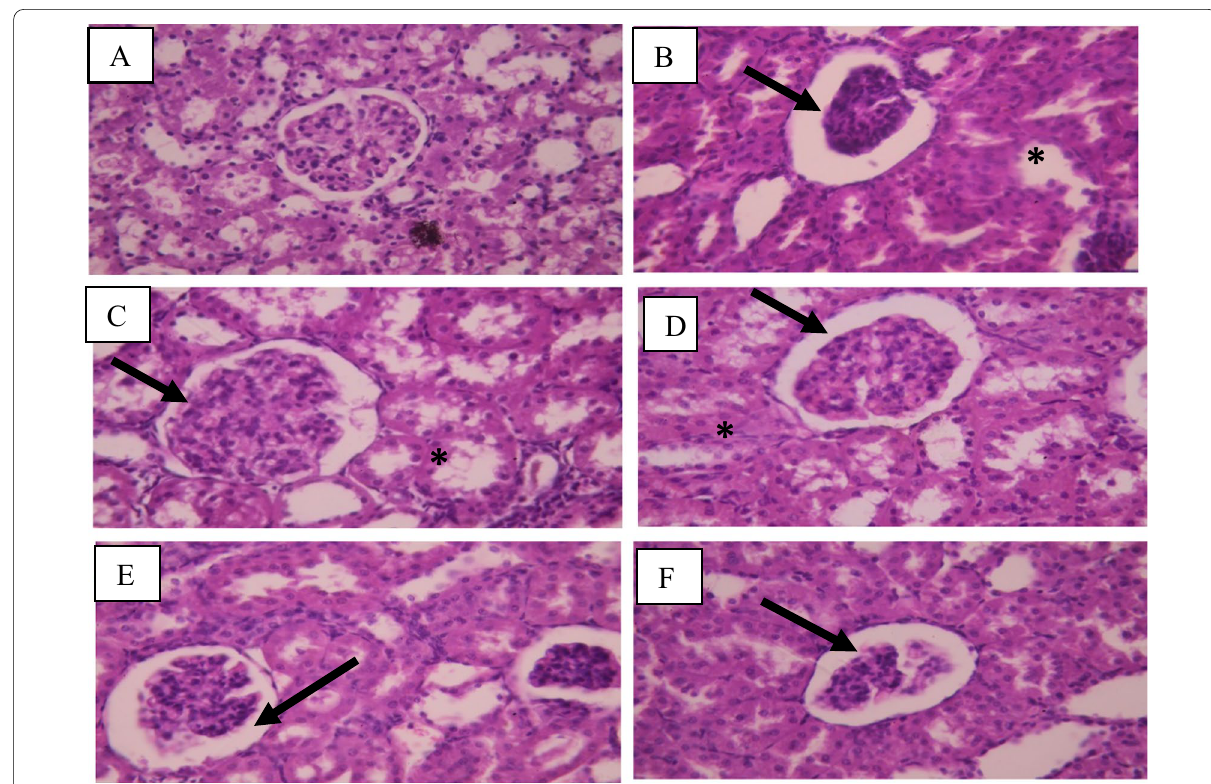
Fig. 1 Sections of kidney remanent of all groups ( 400, H&E): A Control group: normal appearance of renal tissue; B CKD group: Widening of × Bowman’s capsule and tuft retraction ( ), shedding of epithelial cells ( * ); C Early probiotic CKD: No widening of Bowman’s capsule ( ↑ brush border of tubular cells ( * ); D Late probiotic CKD: Widening of Bowman’s capsule ( ) and interstitial damage ( * ); E Early symbiotic CKD: ↑ normal glomerulus, no widening of Bowman’s capsule ( ) and no tuft retraction, and F Late symbiotic CKD: atrophied glomerulus and widening of ↑ Bowman’s capsule